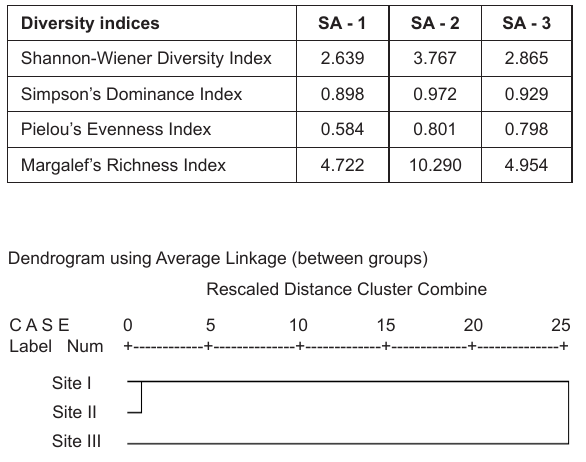
Figure 2. Dendrogram showing the relationship between the three study areas where study area - 1 and study area - 3 with relatively lesser avian diversity were found to form a close